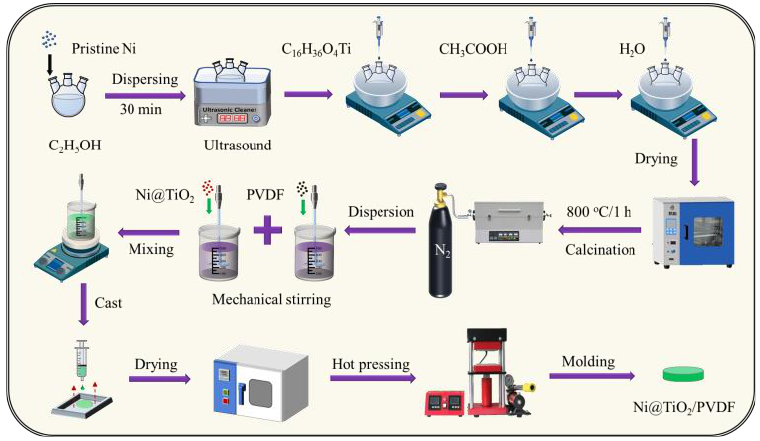
Figure 1. Schematic diagram of the preparation of Ni@TiO 2 particles and corresponding Figure Ni@TiO 2 /PVDF composites.